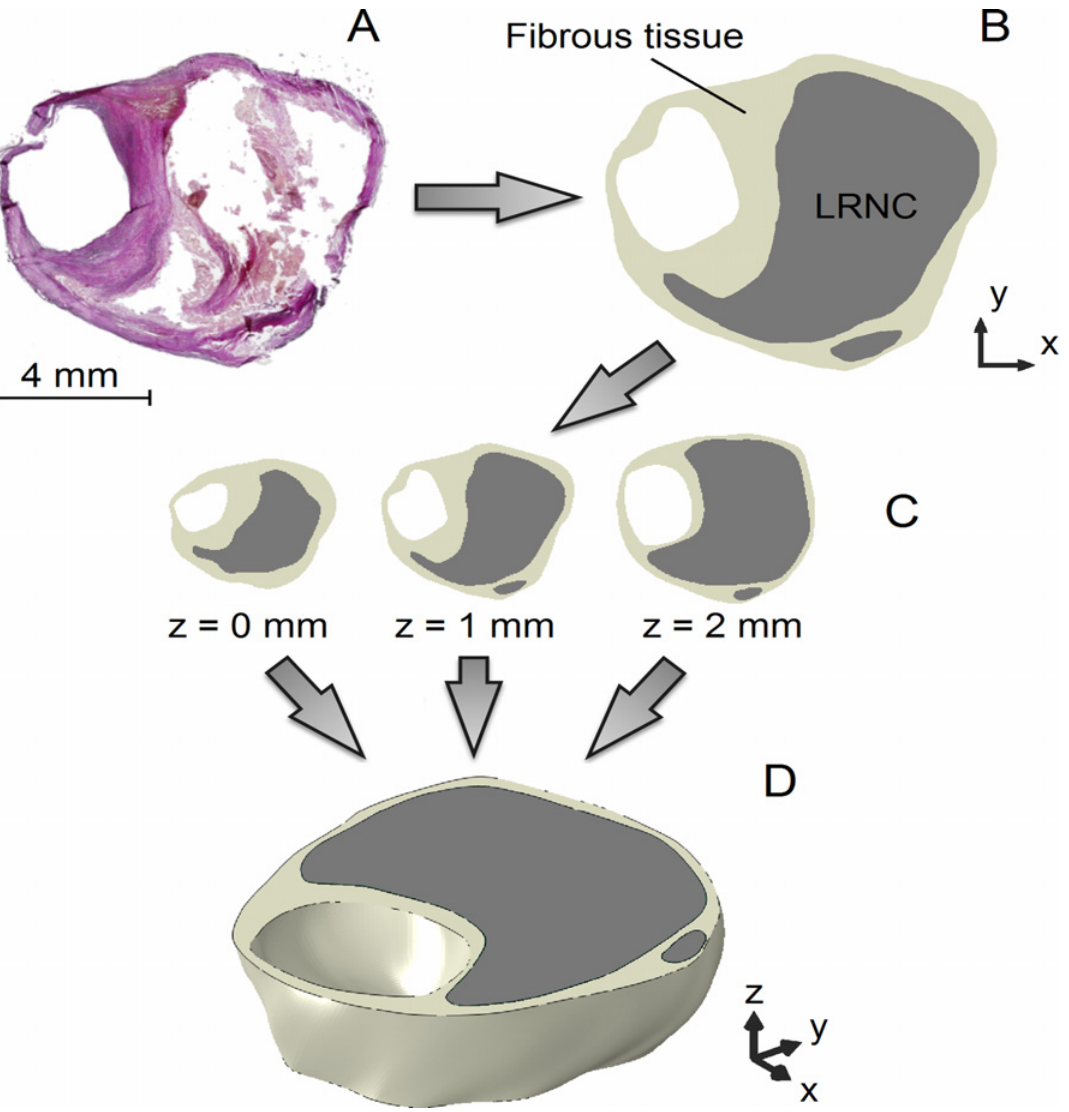
Fig 1. The reconstruction procedure of a 2-mm thick 3D ground truth carotid plaque model illustrated using an example. (A) Histological section, (B) segmentation of the microscopy image, (C) combination of three cross sections, and (D) reconstructed, interpolated, 3D ground truth plaque